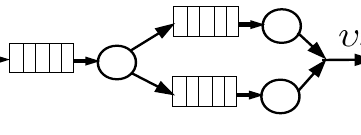
Figure 6: Diamond network.